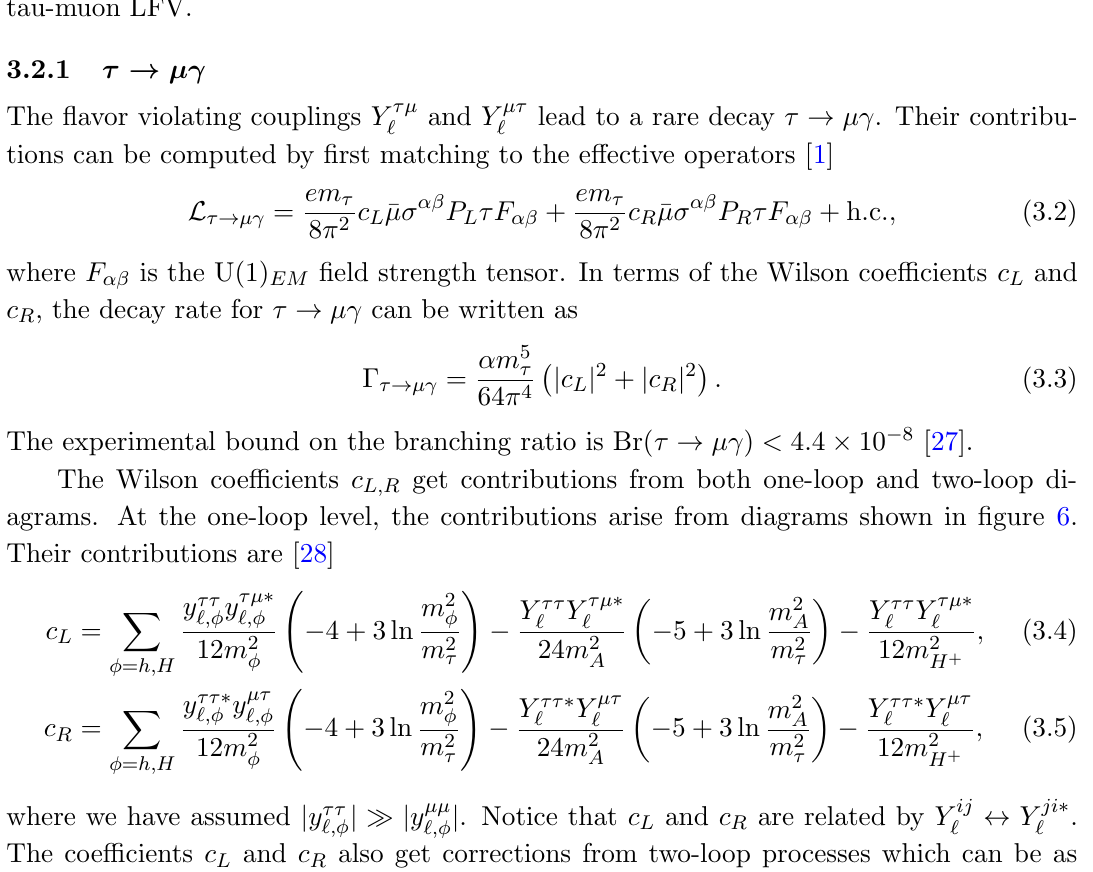
(cid:22)(cid:13) decays induced by the Higgs bosons ! and Y (cid:22)(cid:28) ‘ ‘